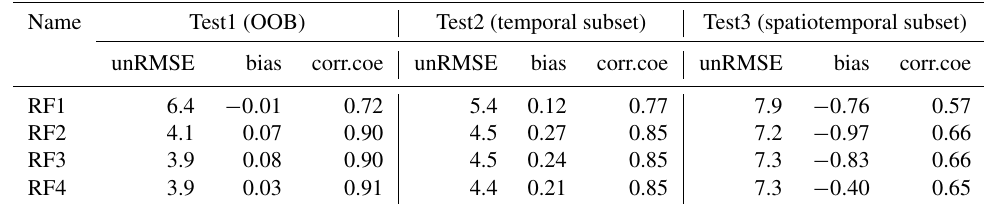
Table 4. Accuracy of four snow-depth retrieval models with unbiased RMSE, bias and correlation coefficient.